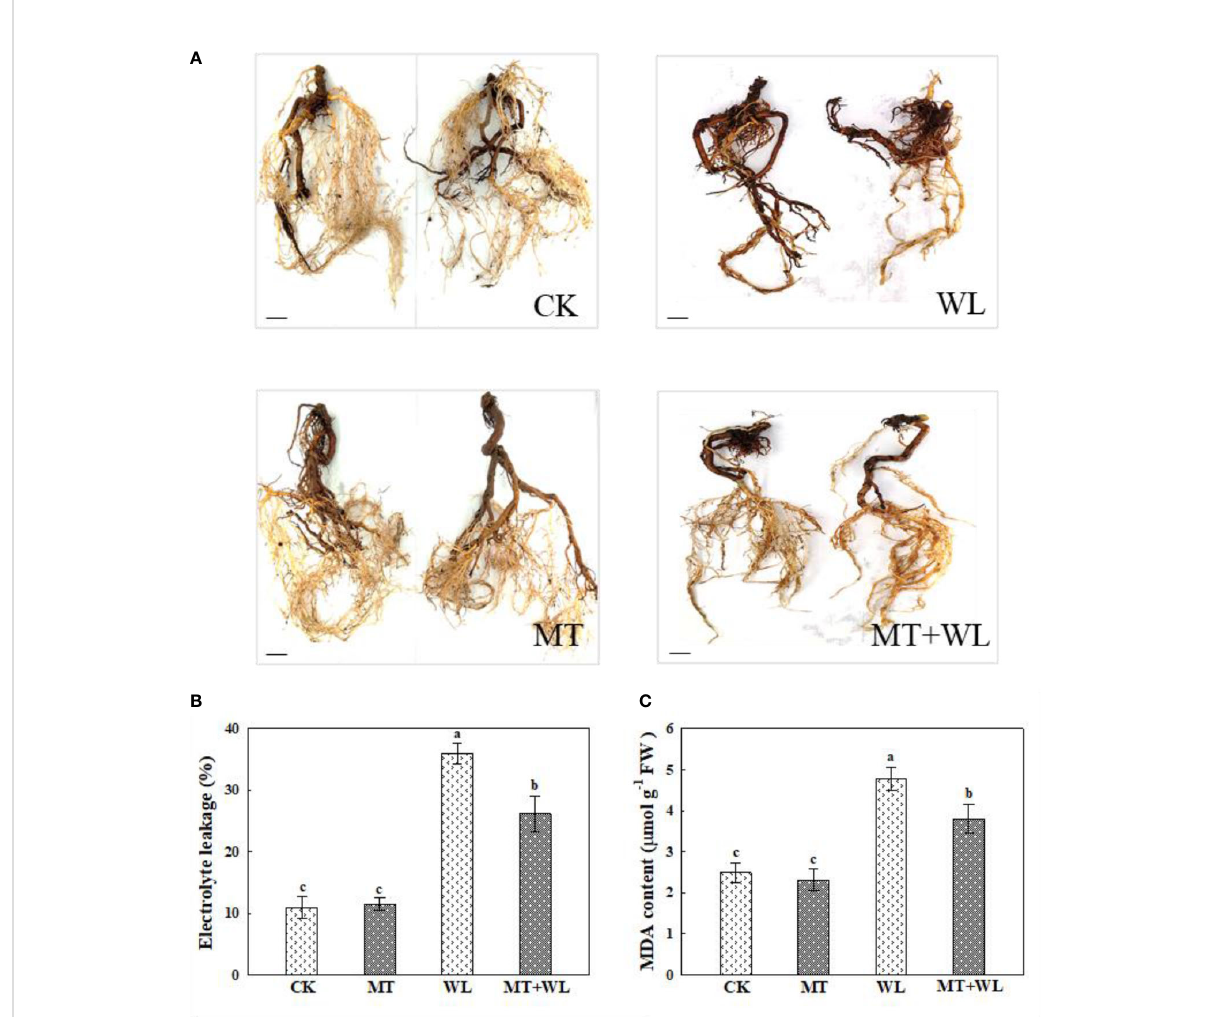
FIGURE 3 Exogenous melatonin alleviated the waterlogging damage on the roots of kiwifruit plants. (A) Phenotypes of the roots of kiwifruit plants in CK, MT, WL, and MT+WL groups, and the plants in WL and MT+WL groups were being waterlogged for 9 days. Bars: 5 cm. (B) Relative electrolyte leakage (REL) and (C) malondialdehyde (MDA) concentration in the roots of CK, MT, WL, and MT+WL plants. Data are shown as the means of three replicates with SEs. Different letters indicate signi fi cant differences between treatments, according to one-way ANOVA and Tukey ’ s multiple range test (P <